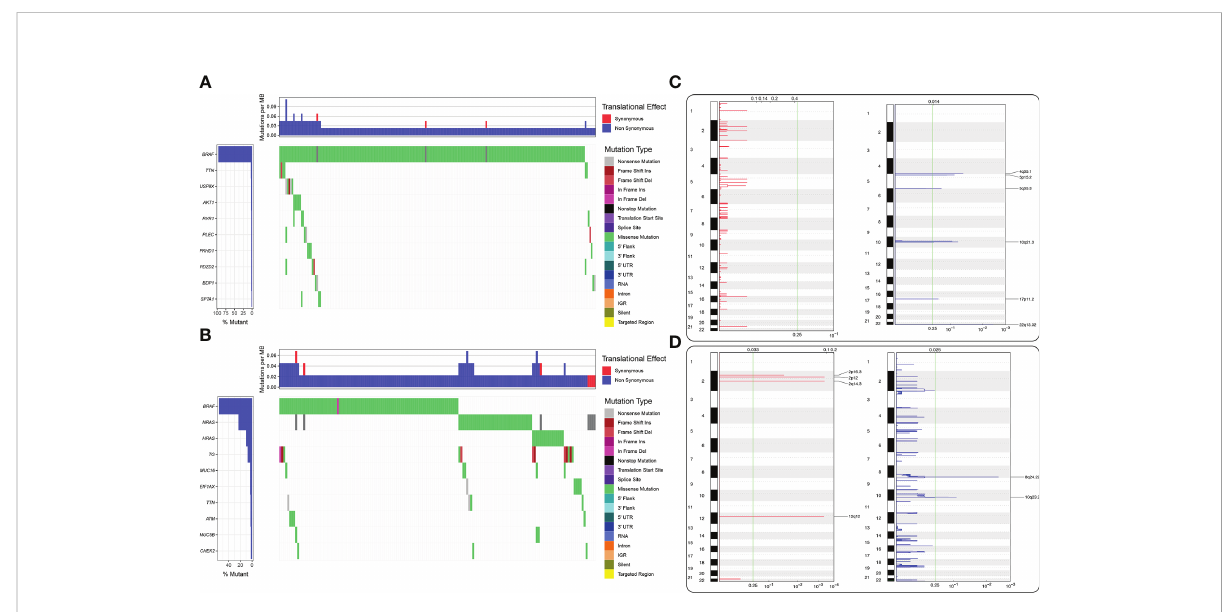
FIGURE 8 Differential mutational landscape in the high and low SIGLEC15 mRNA expression groups. (A) Genes were ranked according to the mutational frequency. SNV and Indel mutations in the high SIGLEC15 mRNA expression group. (B) Genes were ranked according to the mutational frequency. SNV and Indel mutations in the low SIGLEC15 mRNA expression group. (C, D) CNV landscape of (C) ampli fi cation and (D) deletion in the high and low SIGLEC15 mRNA expression groups; the chromosome was oriented vertically from top to bottom and GenePattern GISTIC2.0 q-value at each locus was placed from left to right. The green line displayed the cutoff value of q-value =